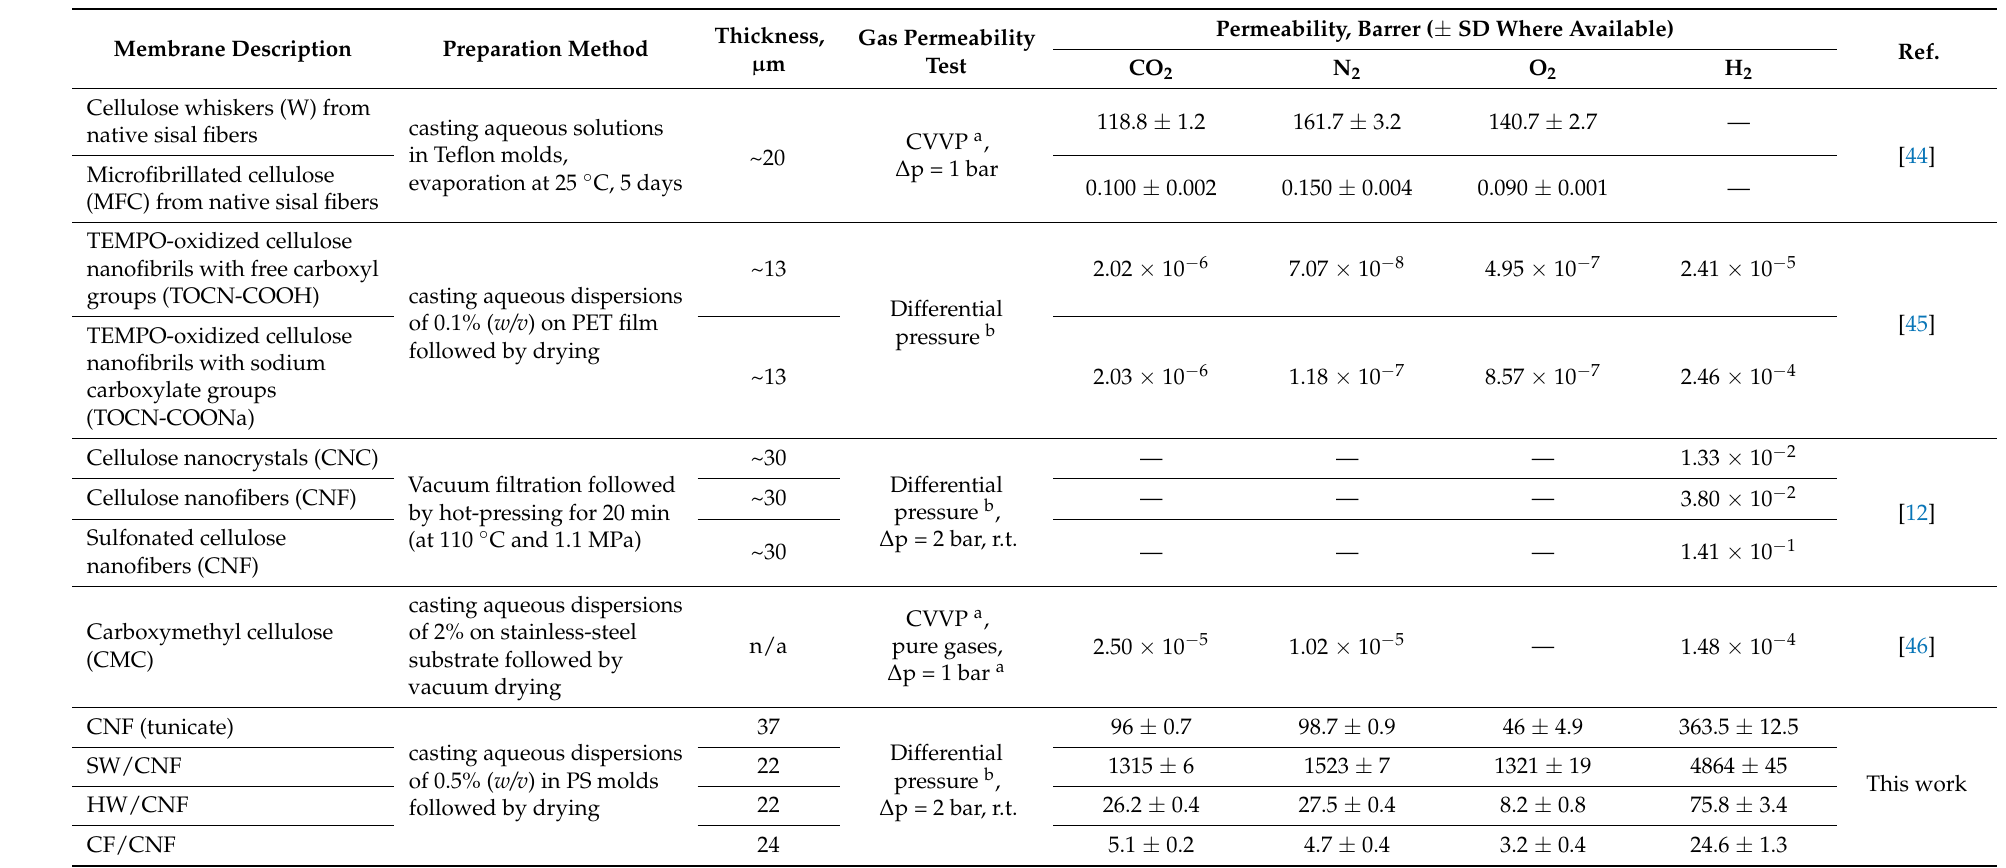
Table A1. Comparison of the gas permeability values of the developed lignin–CNF membranes with examples from the